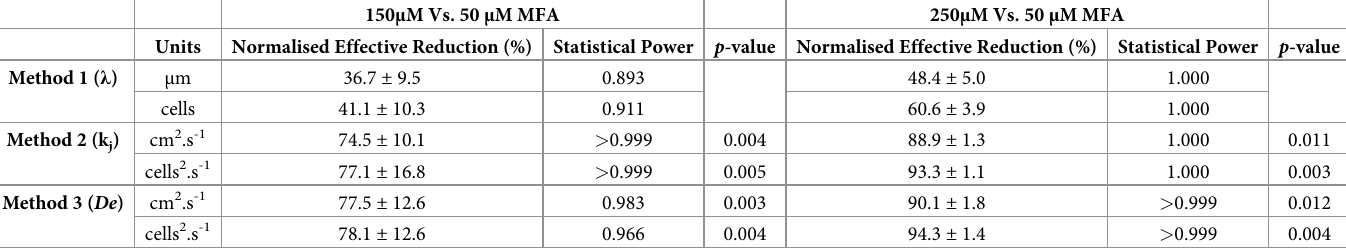
Table 3. Reduction in cell coupling induced by the coupling inhibitor MFA, presented as a percentage reduction from a low-dose baseline concentration. p -values indicate the statistical difference in calculated normalised effect sizes compared to Method